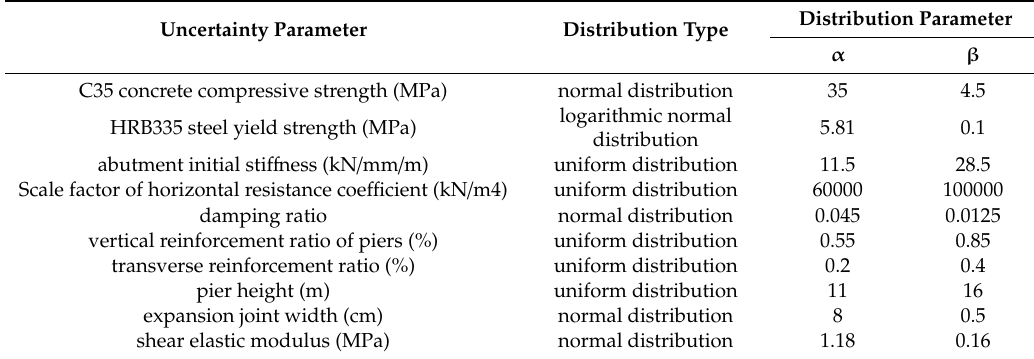
Table 7. Uncertainty parameter distribution.